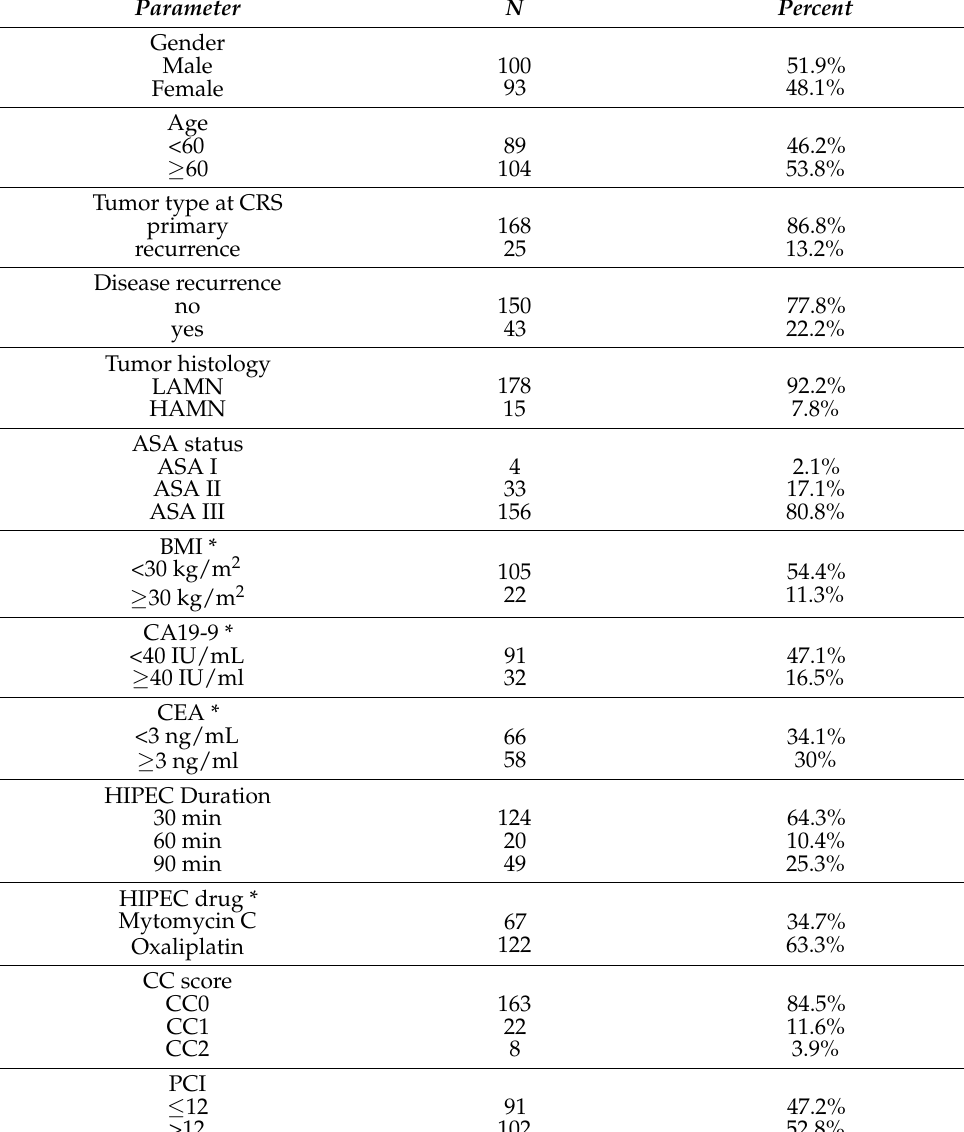
Table 1. Clinicopathological characteristics of study cohort. Cut-offs for CA19-9 and CEA plasma levels and for PCI were defined by receiver operating characteristic (ROC) curve analysis using binary outcomes. Parameter